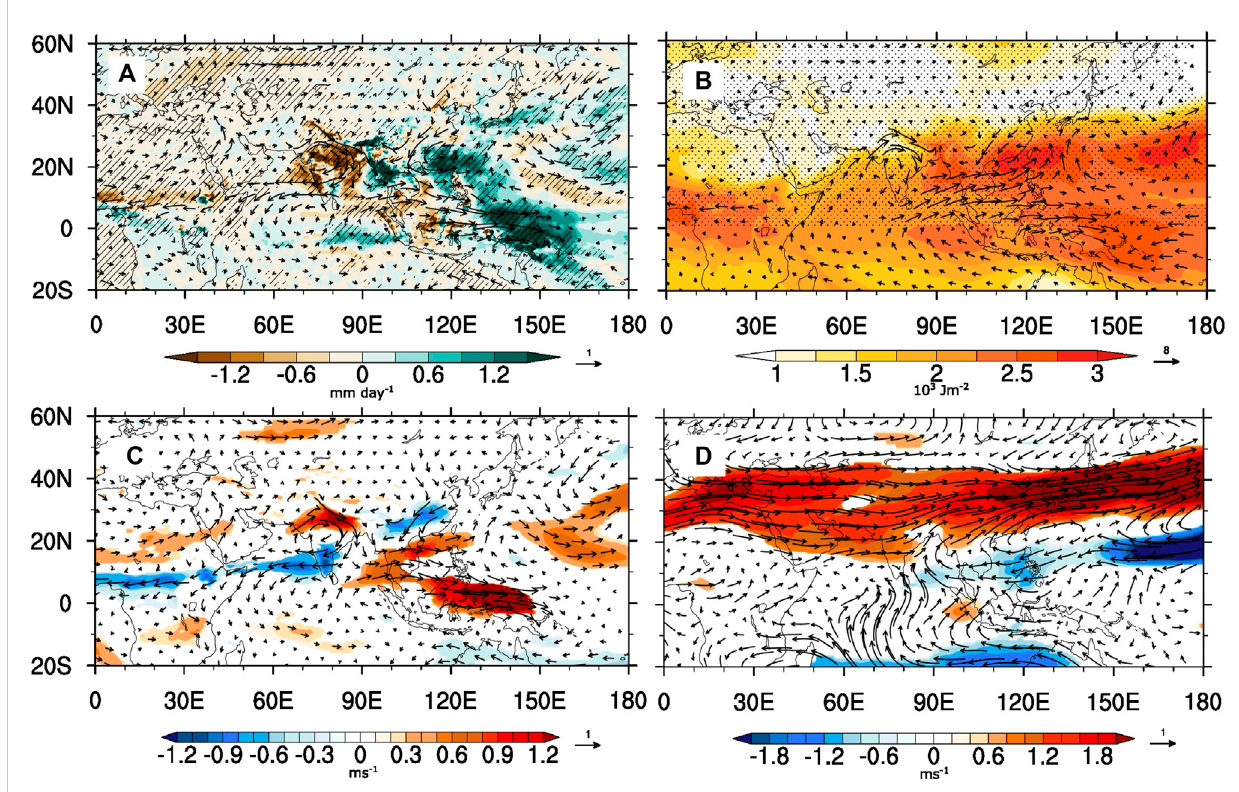
FIGURE 4 Difference (HIST- HISTNAT)maps oftheJJAS time-mean fi elds forthe period(1951 – 2005): (A) Precipitation(mm day -1 )and850 hPa winds(vector; ms -1 ). Areas with statistical signi fi cance ( p < 0.01) are shown by hatched lines (B) MSE (10 3 Jm -2 ) (shaded) and moisture transport (vector; kgm -1 s -1 ) vertically averaged from surface to 300 hPa. Dots indicate statistical signi fi cance ( p < 0.01) based on Student ’ s t-test (C) 850 hPa zonal wind speed (shaded) and winds (vector) (D) 200 hPa zonal wind speed (shaded) and winds (vector). Note that only statistically signi fi cant ( p < 0.01) zonal winds are shown (shaded) in c and